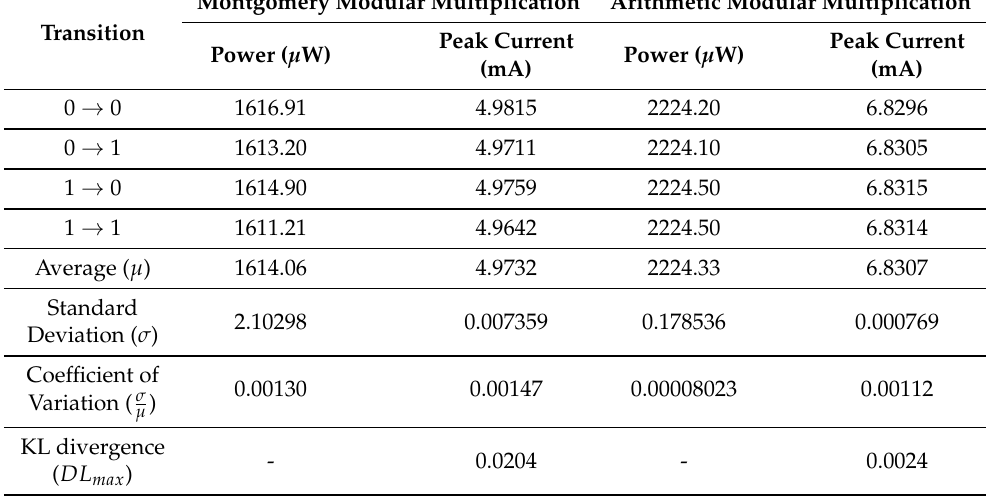
Table 6. SCA metrics for modular multiplication.